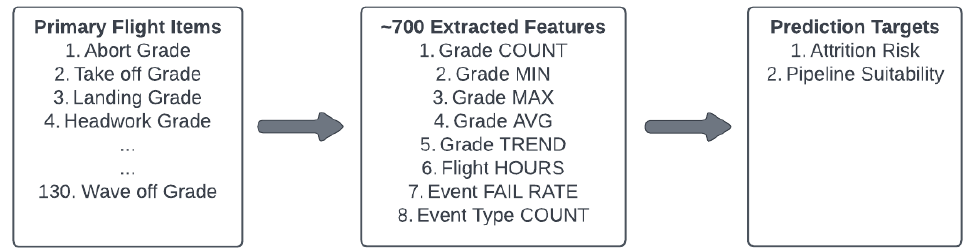
Figure 7. Prediction targets and SME-guided features extracted from flight-graded items.